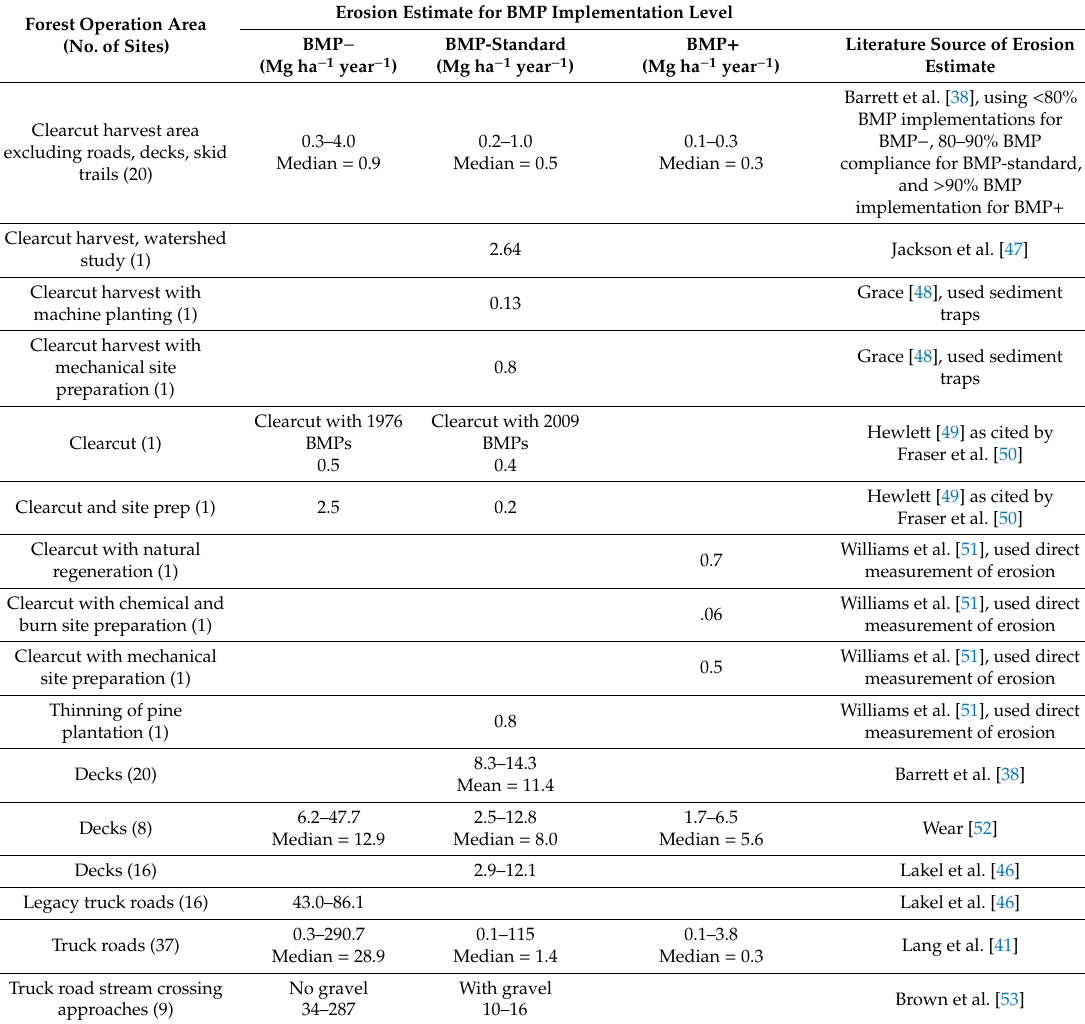
Table 4. Research studies located within the Southern Piedmont that provided an estimate of erosion for a forest operation area and an identified BMP